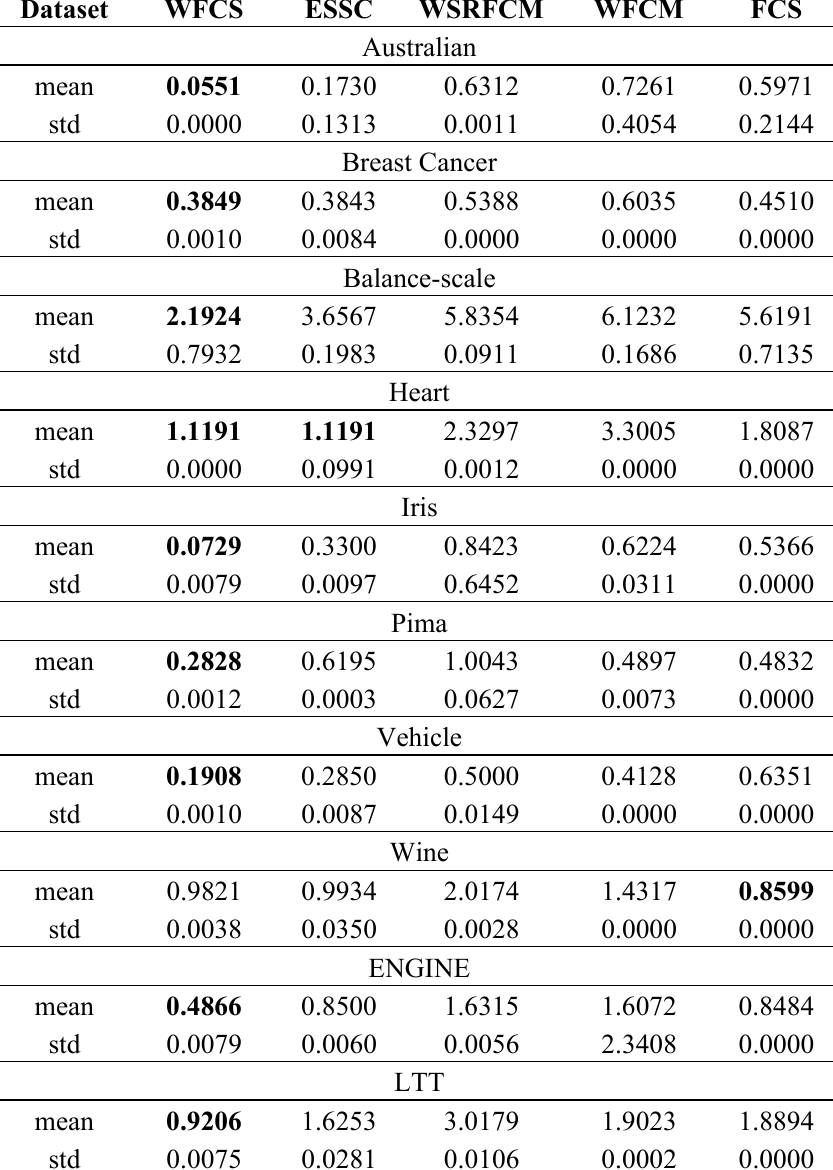
Table 6. Within-Between(WB) index of